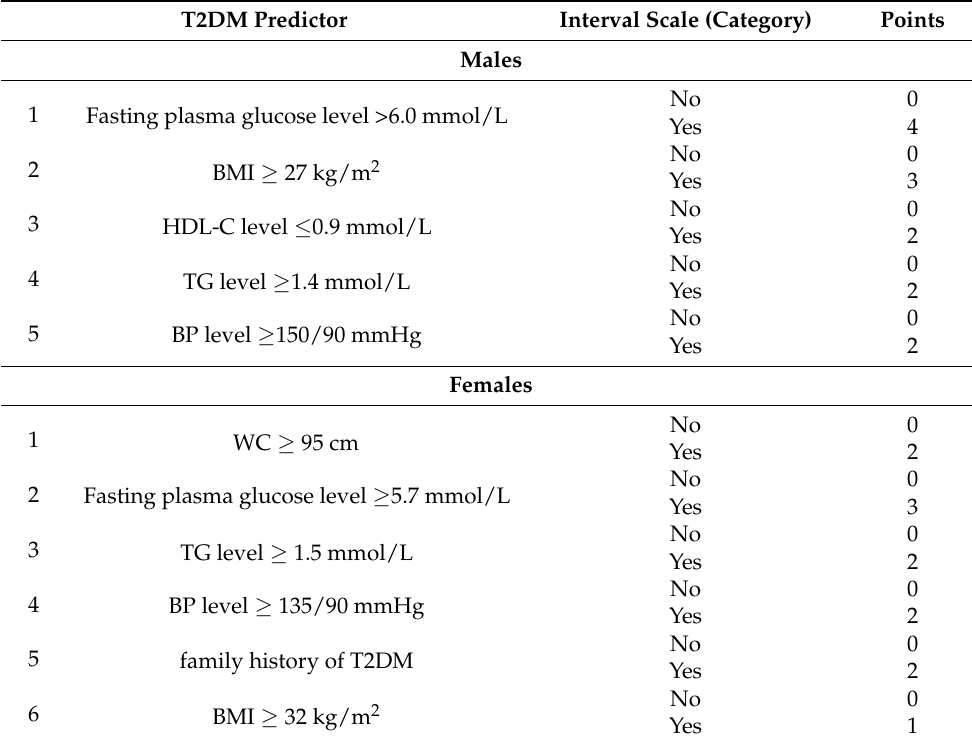
Table 4. The 10-year risk scale for incident